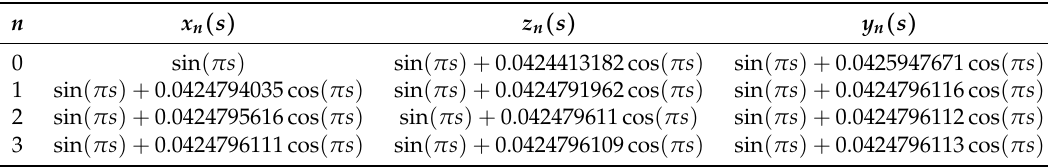
Table 2. Iterates of Newton-like method Equation